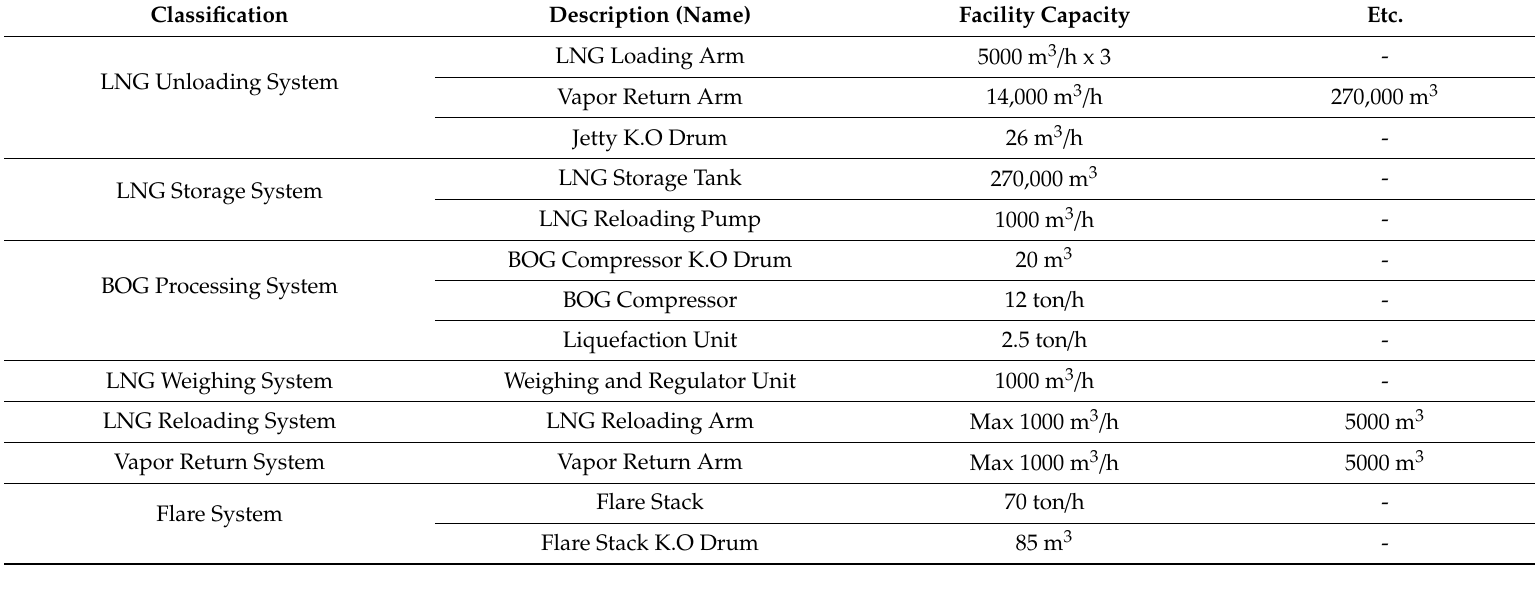
Table A15. LNG On-shore Facility.